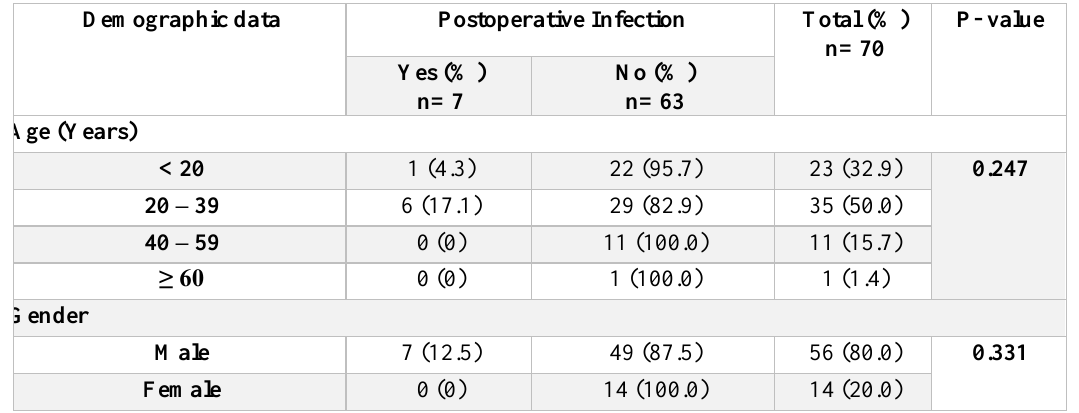
Table (3): Association between incidence of postoperative infection and certain